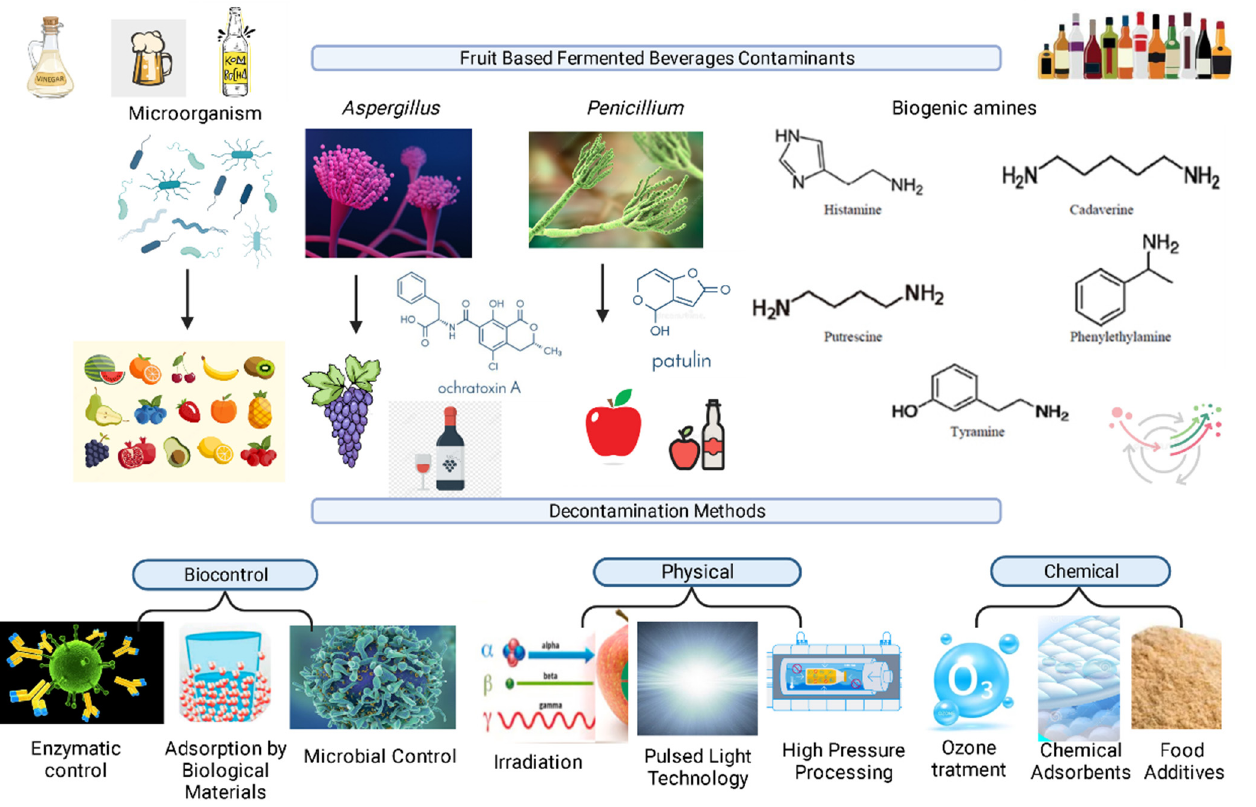
Figure 1. The main contaminants of fruit-based fermented beverages and the removal techniques.